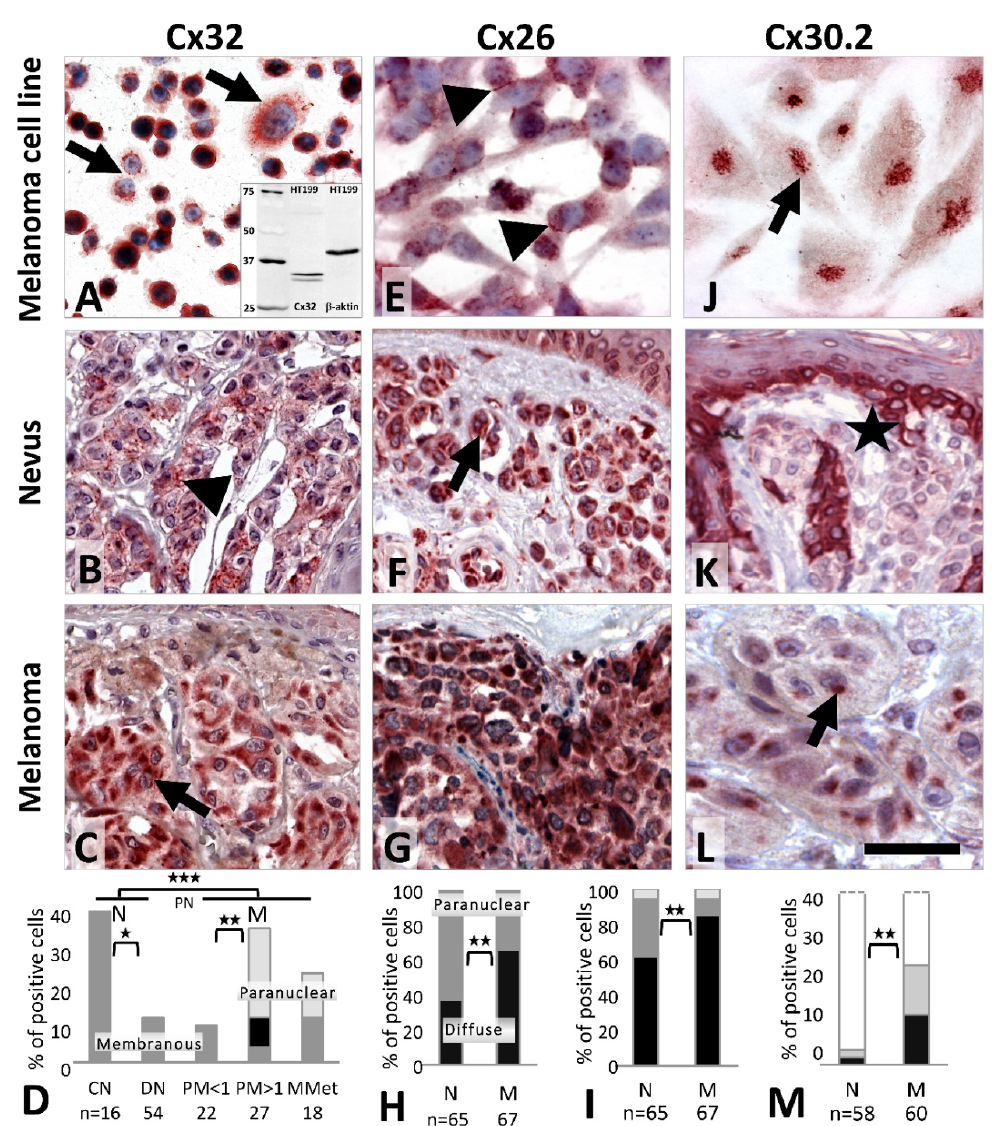
Figure 3. Cx32 ( A – C ), Cx26 ( E – G ) and Cx30.2 ( J – L ) immunoperoxidase reactions (AEC: red),